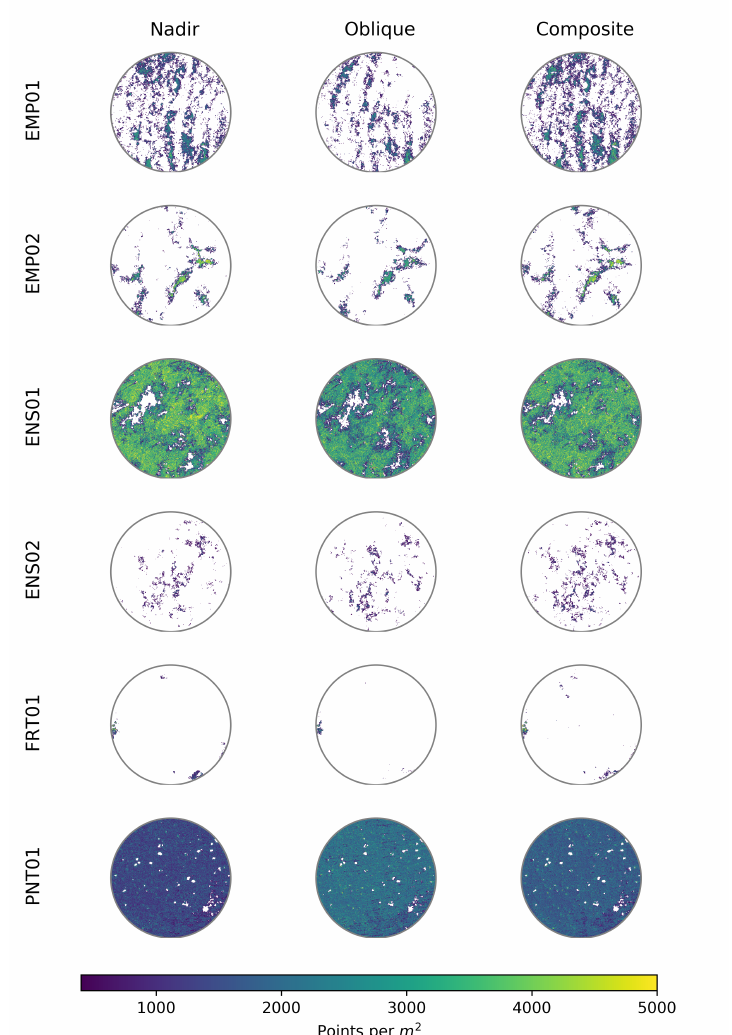
Figure 1. Distribution of ground points within a 15m radius of the plot centre for each plot and image